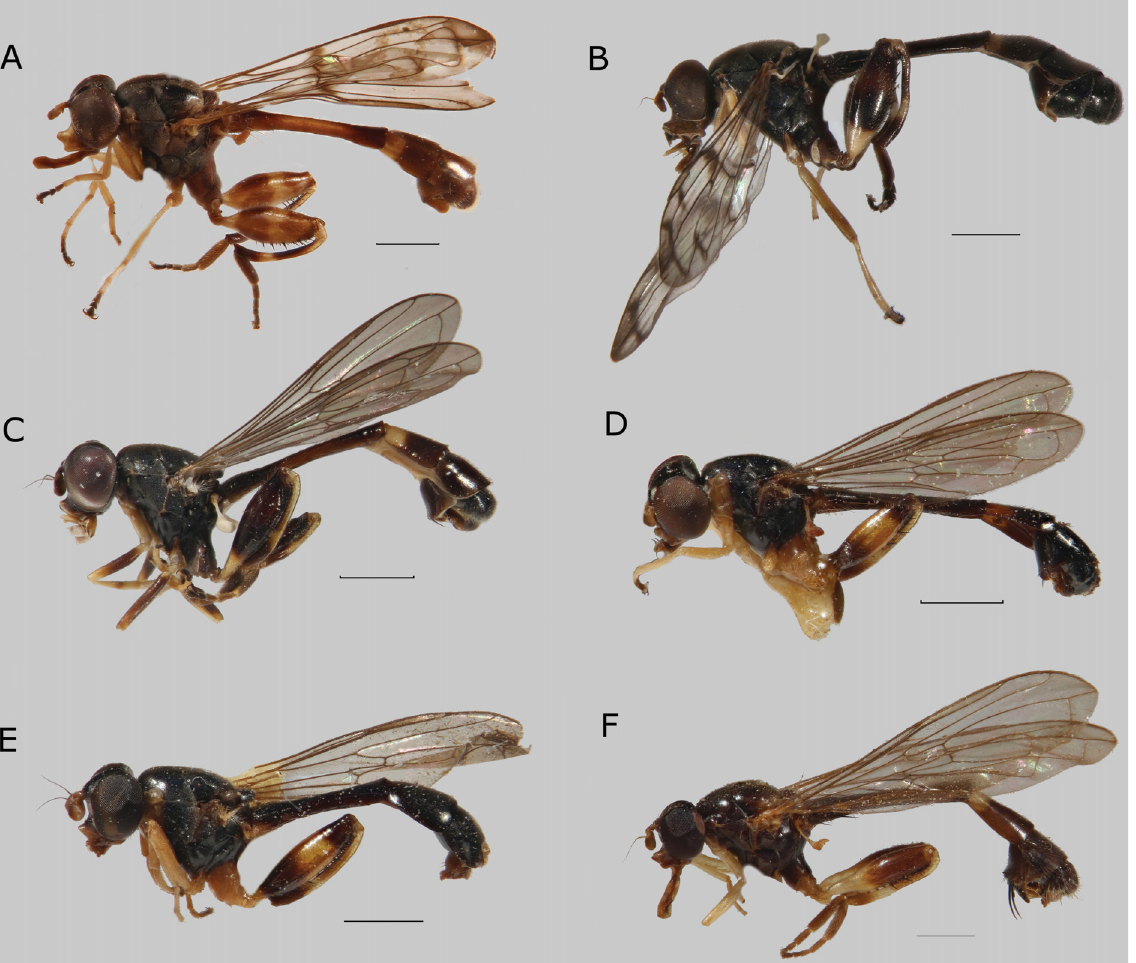
Fig. 56. Habitus, lateral view. A. S. (A.) karnataka sp. nov., paratype, ♂ , India. B . Sphegina (Asiosphegina) licina sp. nov., holotype, ♂ , Thailand. C . S. (A.) lobulata sp. nov., paratype, ♂ , Vietnam. D . S. (A.) lucida sp. nov., paratype, ♂ , Vietnam. E . S. ( A.) lucida sp. nov., paratype, ♀ , Vietnam. F . S. ( A.) malaisei Hippa, van Steenis & Mutin, 2015, paratype, ♂ , Myanmar. Scale bars =